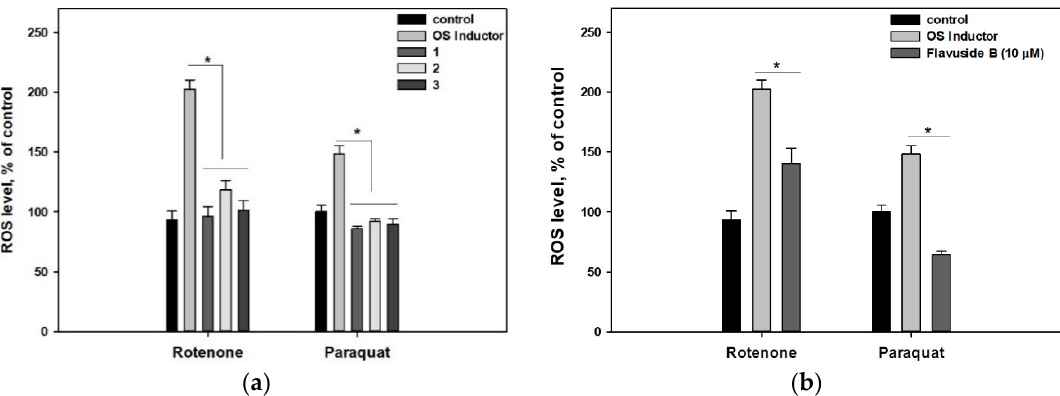
Figure 4. Influence of polyketides 1 – 3 ( a ) and flavuside B 4 ( b ) on ROS level in Neuro-2a cells treated with OS inductors, rotenone and paraquat. Data are presented as mean ± standard error mean (SEM). * indicates significant differences ( p ≤ 0.05). Differences between control and rotenone or paraquat were significant.